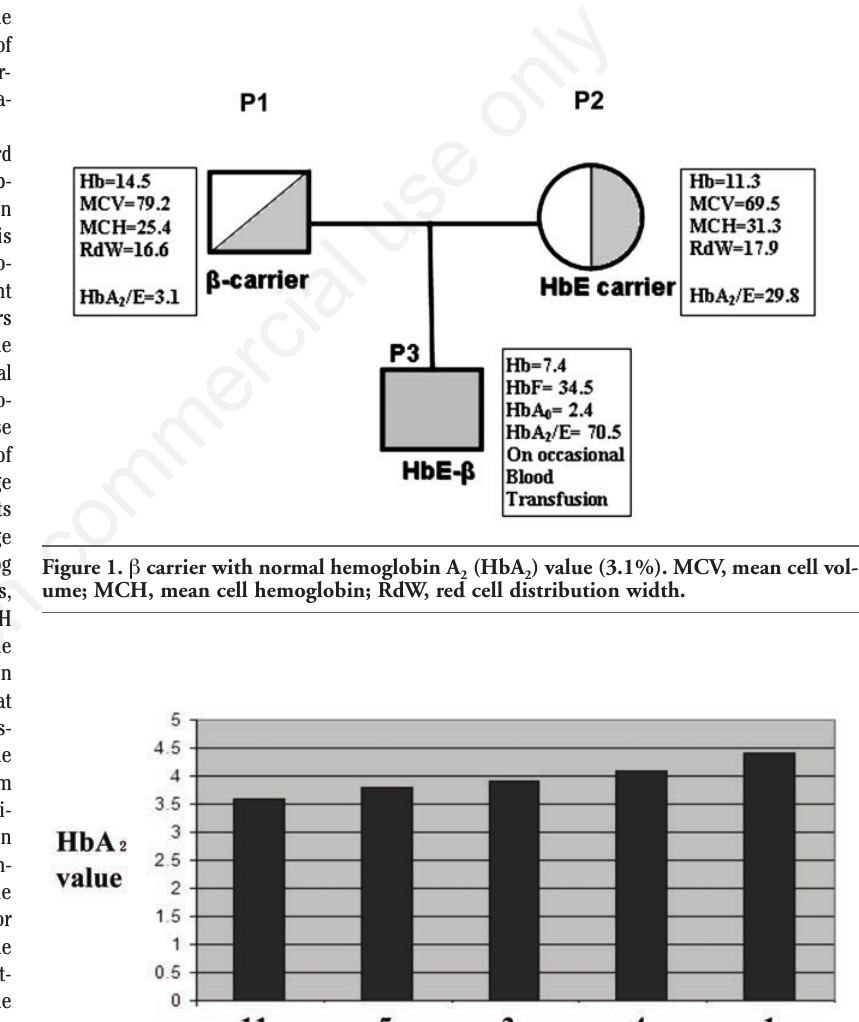
Figure 2. Normal participants with abnormally high hemoglobin A